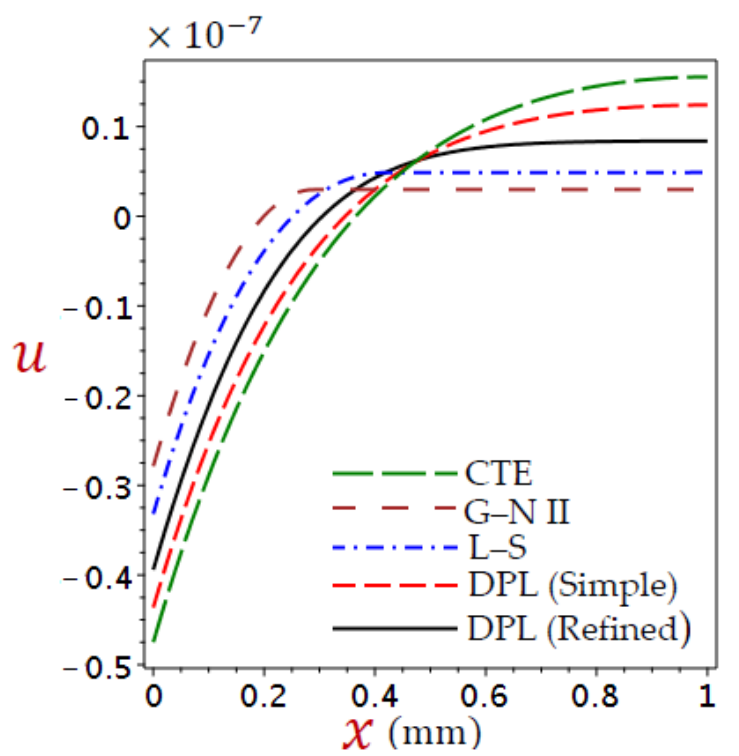
Figure 3. Comparison of variation of displacement (𝑢) across the skin tissue utilizing numerous theories.